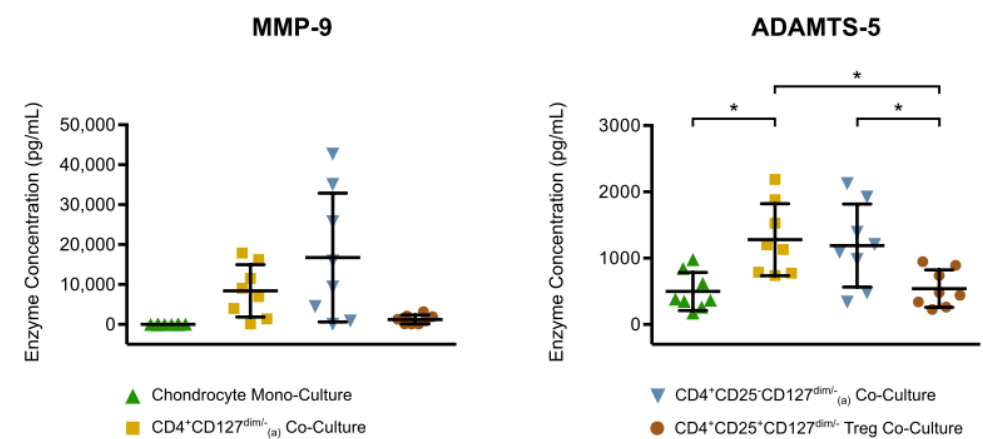
Figure 6. Quantitative analysis of MMP-1/-3/-9 and ADAMTS-5 concentration in chondrocyte monocultures and co-cultures with different CD4 + mononuclear cell subtypes is displayed. Chondrocytes harvested from tibial plateau of patients with advanced knee OA were isolated. A population of CD4 + CD127 dim/- -enriched PBMC and two subpopulations consisting of CD4 + CD25 - CD127 dim/- -enriched PBMC (Treg-depleted enriched PBMC) and CD4 + CD25 + CD127 dim/- Treg were isolated from heparin anti-coagulate peripheral blood using Ficoll-PlaqueTM and magnetic activated cell sorting. Chondrocytes monocultures and co-cultures were incubated for 48 h at 37 °C and then enzyme concentrations in culture supernatants were analyzed performing enzyme-linked immunosorbent assays. The mean and standard deviation of enzyme concentrations of MMP-1/-3/-9 and ADAMTS-5 are plotted ( n = 8). Significant differences are indicated by asterisks: * p < 0.05.